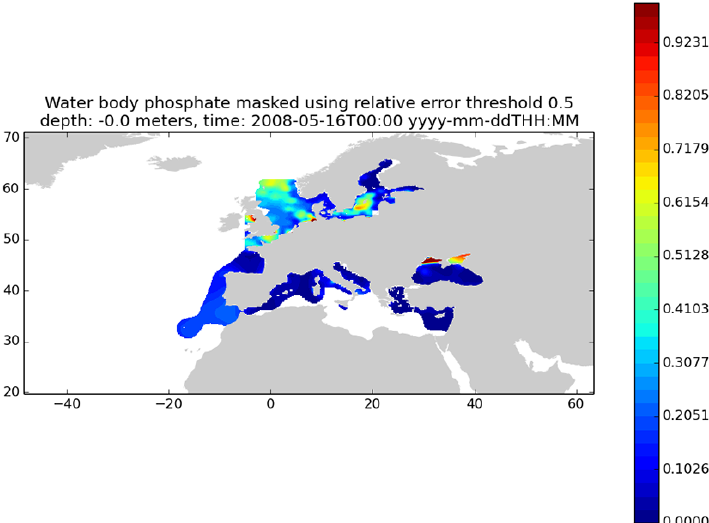
Figure 6. Ten-year average of water body phosphate concentration (µmolPL − 1 ) in the surface layer for all EU sea basins (years 2003–2013). Interpolated maps can be selected from the Ocean Browser viewing service interface with the following steps: choose “Select data products” button, scroll and choose in the pop-up window from the list of available products, and then select “Add layer” in the lower left corner of the pop-up window. Maps can also be downloaded in different formats obtaining results as in this example (PNG file).